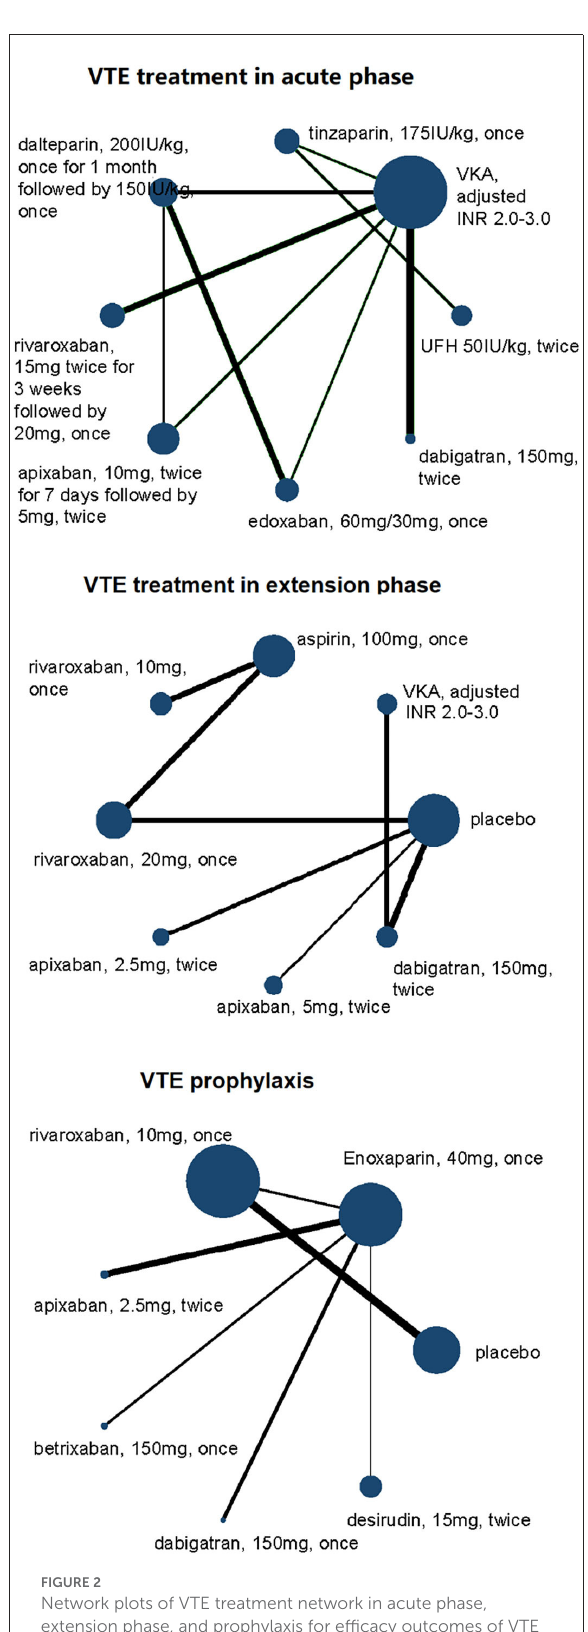
FIGURE2 Network plots of VTE treatment network in acute phase, extension phase, and prophylaxis for efficacy outcomes of VTE patients with renal insufficiency. All drugs are present as daily dose and frequency. VTE, venous thrombus embolism; VKA, vitamin K